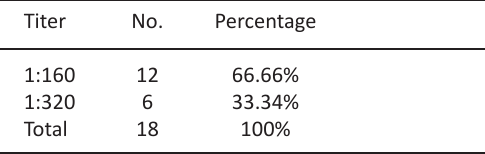
Table 3. Distribution of Brucella patients according the antibodies titer with RBT.